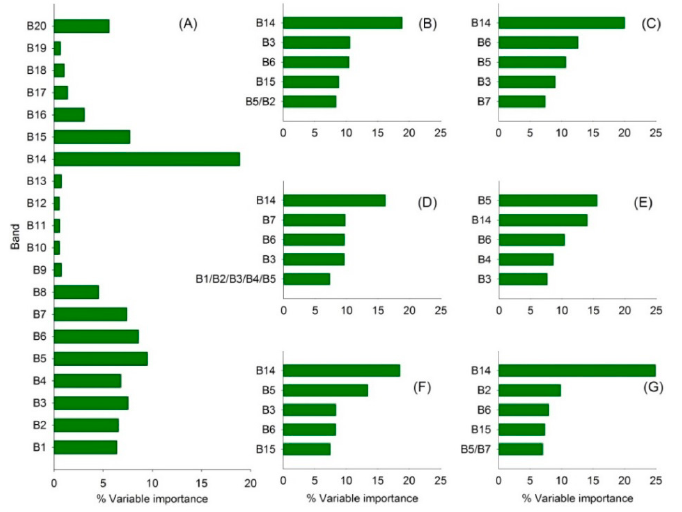
Figure 3. Measurement of the relative variable importance of the predictor variables in the adjusted Random Forests for classifying: ( A ) complete land cover classification; ( B ) forest class; ( C ) palm forest classes; ( D ) settlement class; ( E ) grassland class; ( F ) pineapple class; ( G ) coffee class. Despite the high number of Landsat images processed and classified in each year of the time series, a small percentage of pixels remained without classification due to clouds and shadows (Figure 4). However, this percentage is less than 2% of the country for every year in the series.